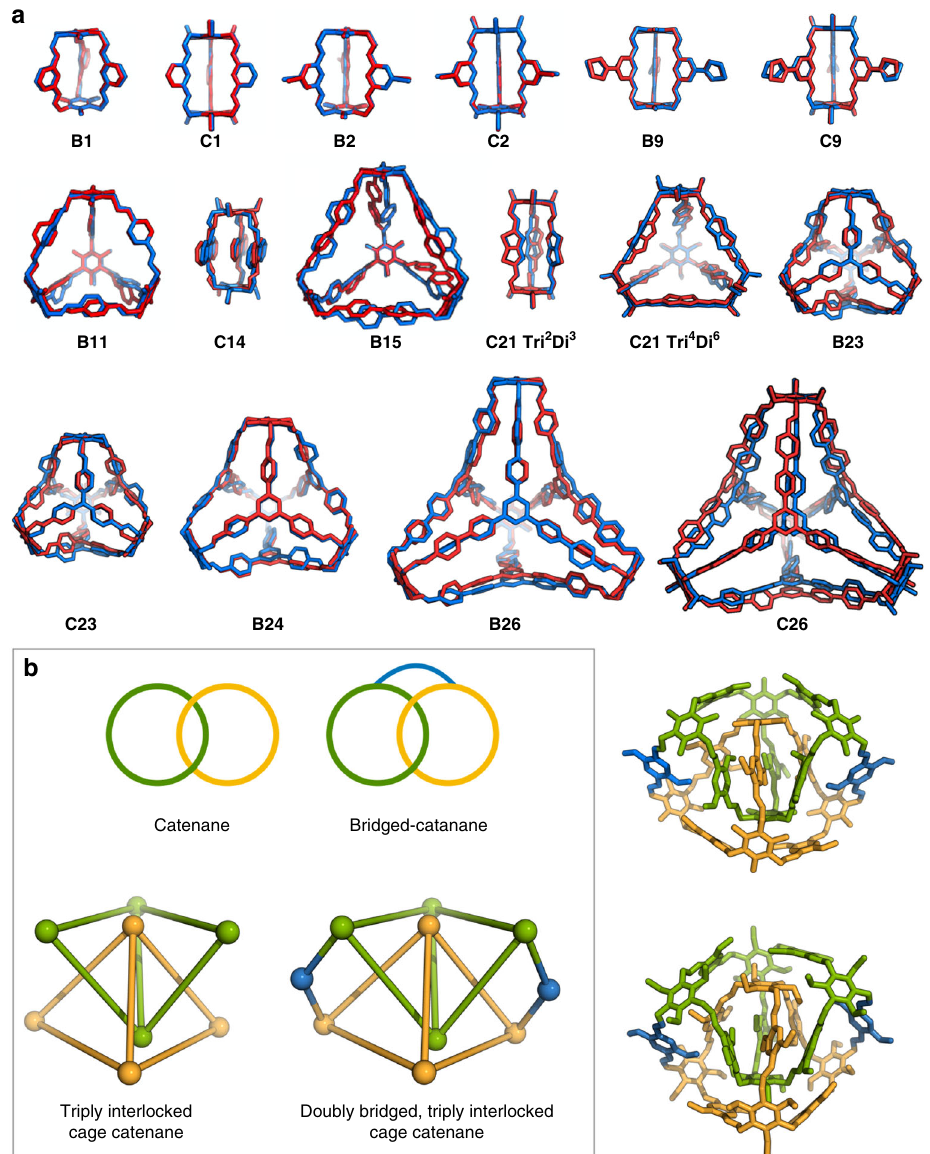
Fig. 5 Crystal structures of cages and bridged cage catenanes. a Comparison of modelled and experimental cage structures — overlays of available single crystal X-ray structures for each cage (red) with the computed lowest energy conformation (blue). b Crystal structures of the two unexpected [8 + 12] covalently bridged, triply interlocked cage catenanes formed by re-equilibration of targeted cages, B13 and C13 , and comparison of the unique topology with previous catenanes, bridged catenanes, and triply interlocked cage catenanes. The [8 + 12] bridged cage catenane is triply interlocked (symmetry equivalents coloured in yellow and green), but uniquely, it has two different shaped windows and is linked by two covalent bridges (blue). Hydrogens and external functional groups have been removed for clarity. For the full crystal structures see Supplementary Figs. 12 and